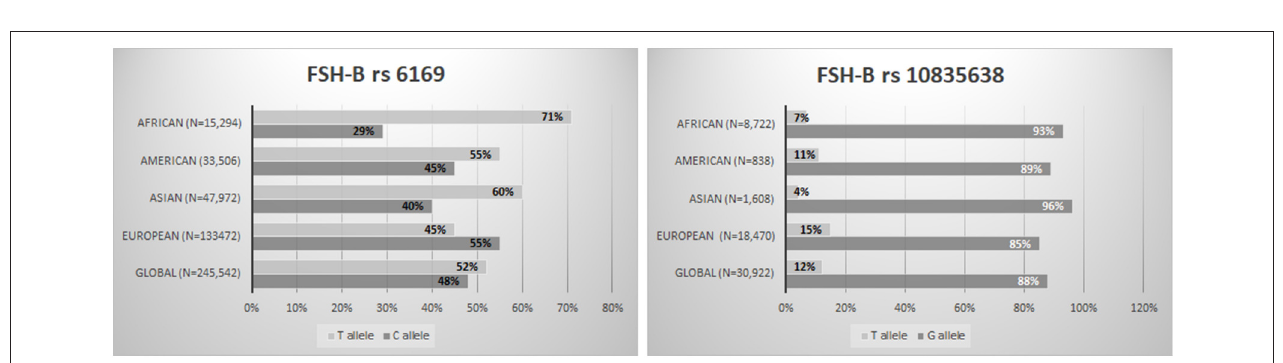
FIGURE 2 | FSH-B subunit variants worldwide distribution ( RS6169; RS10835638 ) (The Genome Aggregation